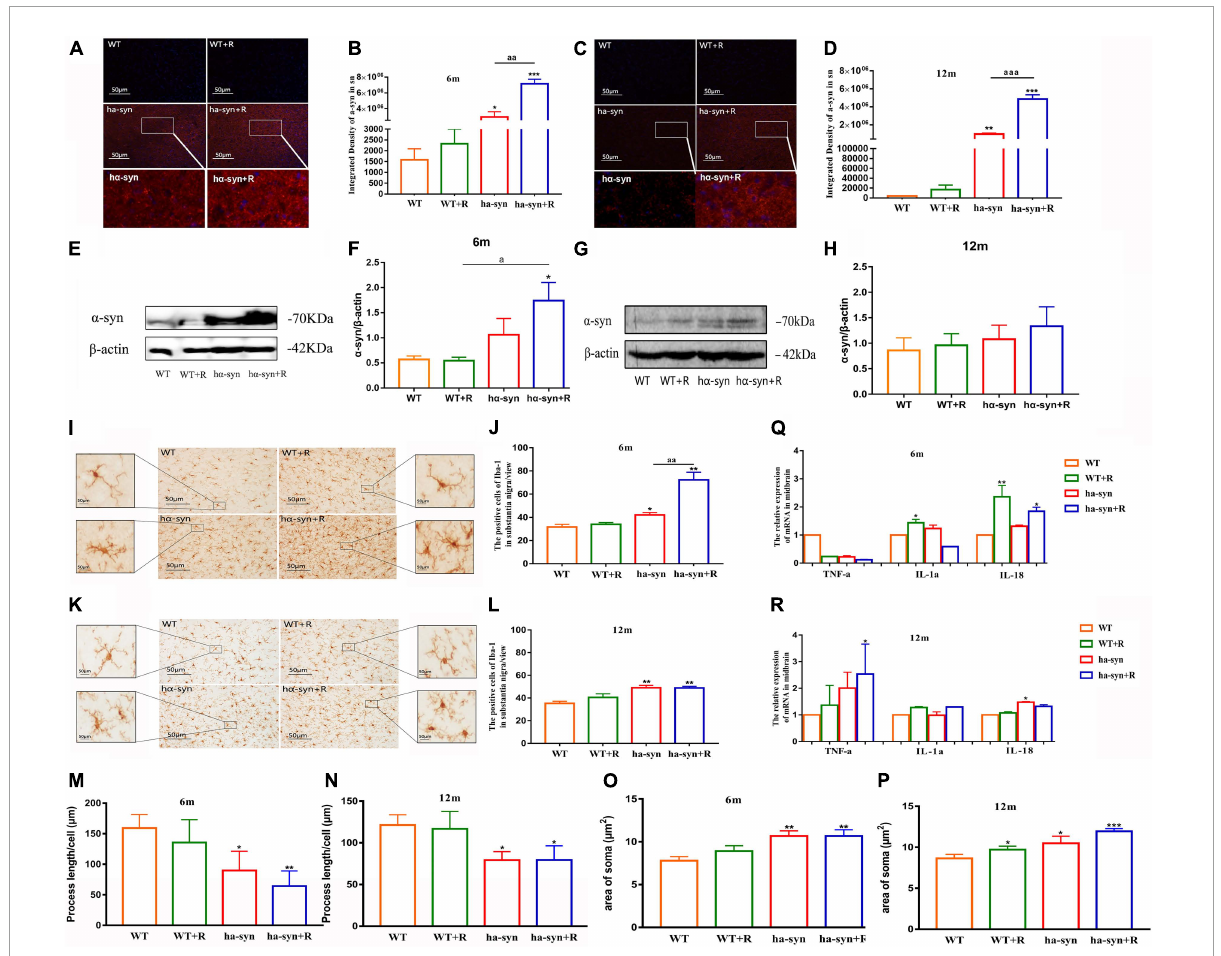
FIGURE3 Rotenone increased the expression of α -syn and promoted the proliferation and heterogeneity of microglia in the SNc of h α -syn + / − mice. Semiquantitative analysis of α -syn expression in SNc by immunofluorescence technique (A–D) . (A) Representative images of α -syn expression in the SNc of 6-month-old h α -syn + / − mice, α -syn (red), DAPI (blue). (B) Fluorescence intensity analysis of α -syn expression in the SNc of 6-month-old h α -syn + / − mice by the ImageJ software. (C) Representative images of α -syn expression in the SNc of 12-month-old h α -syn + / − mice, α -syn (red), DAPI (blue). (D) Fluorescence intensity analysis of α -syn expression in the SNc of 12-month-old h α -syn + / − mice by ImageJ software. Semiquantitative analysis of α -syn expression in the midbrain by Western blot (E–H) . (E) Representative WB images of α -syn expression in the midbrain of 6-month-old h α -syn + / − mice. (F) The WB images of α -syn expression in the midbrain of 6-month-old h α -syn + / − mice were scanned and computed the gray score. (G) Representative WB images of α -syn expression in the midbrain of 12-month-old h α -syn + / − mice. (H) The WB images of α -syn expression in the midbrain of 12-month-old h α -syn + / − mice were scanned and computed the gray score. The number of microglia in SNc of mice of different ages was detected by immunohistochemical technique combined with cell counting (I–L) . (I) Representative images showing Iba-1-positive cells in SNc of 6-month-old h α -syn + / − mice. (J) A number of Iba-1-positive cells in SNc of 6-month-old h α -syn + / − mice. (K) Representative images showing Iba-1-positive cells in SNc of 12-month-old h α -syn + / − mice. (L) A number of Iba-1-positive cells in SNc of 12-month-old h α -syn + / − mice. Morphological analysis of microglia by Image J (M-P) . (M) , Statistical results of process length of microglia at the age of 6 months. (N) , Statistical results of process length of microglia at the age of 12 months. (O) , Statistical results of the area of microglial soma at 6 months old. (P) , Statistical results of the area of microglial soma at 12 months old.Analysis of levels of inflammatory cytokines in the midbrain of mice of different ages by qPCR (Q-R) . (Q) , mRNA level of TNF- α , IL-1 α , IL-18 in the midbrain of 6-month-old mice. (R) , mRNA level of TNF- α , IL-1 α , IL-18 in the midbrain of 12-month-old mice. n = 6. * P < 0.05, ** P < 0.01, *** P < 0.001, compared with the age-matched WT group. a P < 0.05, compared with the age-matched WT + R group. aa P < 0.01, aaa P < 0.001, compared with the age-matched h α -syn + / −